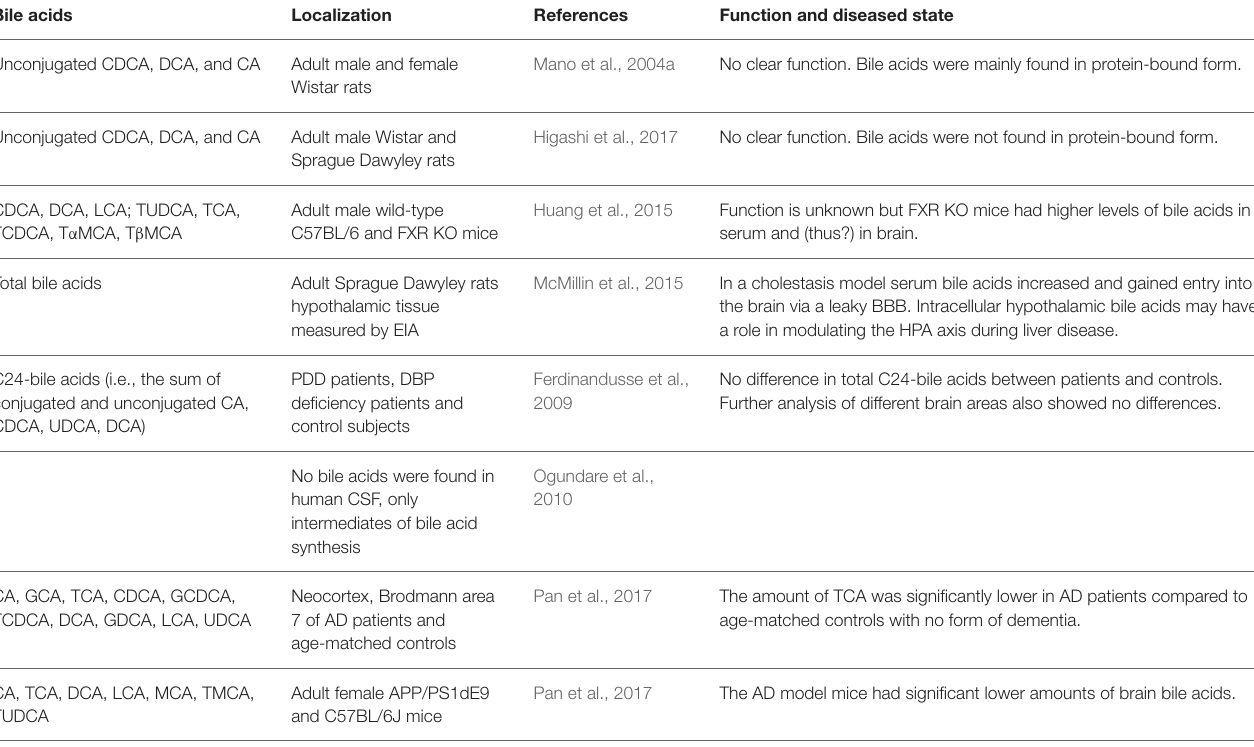
TABLE 2 | Bile acids found in the